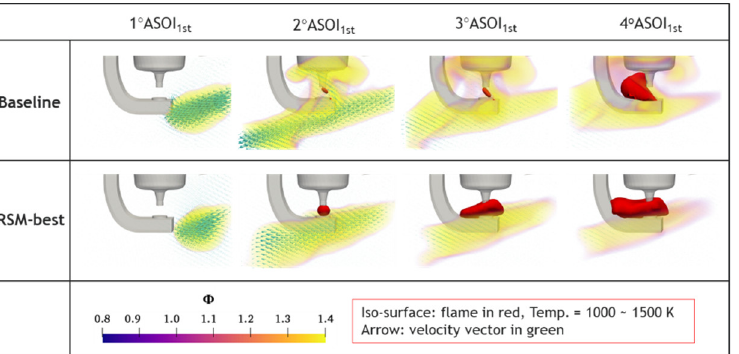
Figure 7. Comparison of local flame development and the distributions of in-cylinder flow and equivalence ratio (Ф) fields near spark gap between baseline and RSM-best cases.